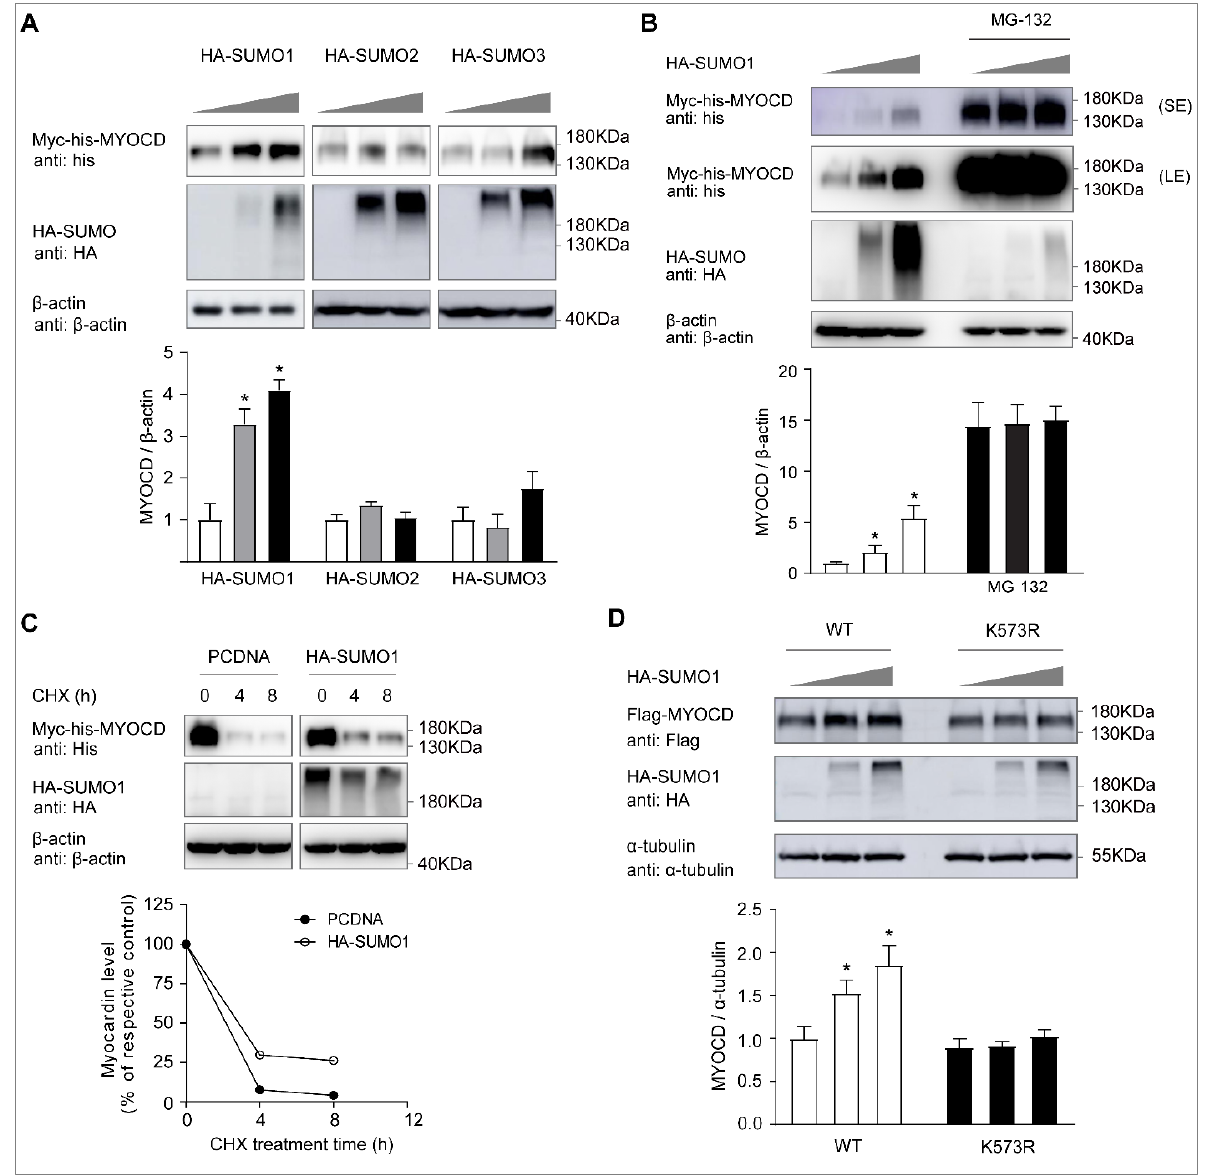
Figure 3. SUMO ‐ 1 promotes the protein stability of myocardin. ( A ) HEK ‐ 293T cells were transfected with Myc ‐ his ‐ myocardin (Myc ‐ his ‐ MYOCD) and increasing amounts of HA ‐ SUMO1, HA ‐ SUMO2, or HA ‐ SUMO3 for 24 h. The levels of Myc ‐ his ‐ MYOCD in whole ‐ cell lysates were determined by Western blotting with anti ‐ his, anti ‐ HA, and anti ‐β‐ actin antibodies (n = 3, * p < 0.05). ( B ) HEK ‐ 293T cells were transfected with Myc ‐ his ‐ MYOCD and increasing amounts of HA ‐ SUMO1 for 24 h, in the presence or absence of MG132 (10 μ M) for the last 10 h. Lysates were prepared and analyzed by Western blotting (n = 3, * p < 0.05). SE, short ‐ time exposure; LE, long ‐ time exposure. ( C ) HEK ‐ 293T cells were transfected with Myc ‐ his ‐ MYOCD and PCDNA or HA ‐ SUMO1 for 24 h and were subse ‐ quently exposed to the protein synthesis inhibitor cycloheximide (CHX) for the indicated time. Ly ‐ sates were prepared and analyzed by Western blotting. The relative level of Myc ‐ his ‐ MYOCD was evaluated by densitometry and normalized to β‐ actin. ( D ) HEK ‐ 293T cells were transfected with Flag ‐ myocardin/WT (Flag ‐ MYOCD/WT) or Flag ‐ myocardin/K573R (Flag ‐ MYOCD/ K573R) and in ‐ creasing amounts of HA ‐ SUMO1 for 24 h. The levels of Flag ‐ MYOCD in whole ‐ cell lysates were determined by Western blotting with anti ‐ Flag, anti ‐ HA, and anti ‐α‐ tubulin antibodies (n = 3, * p < 0.05).